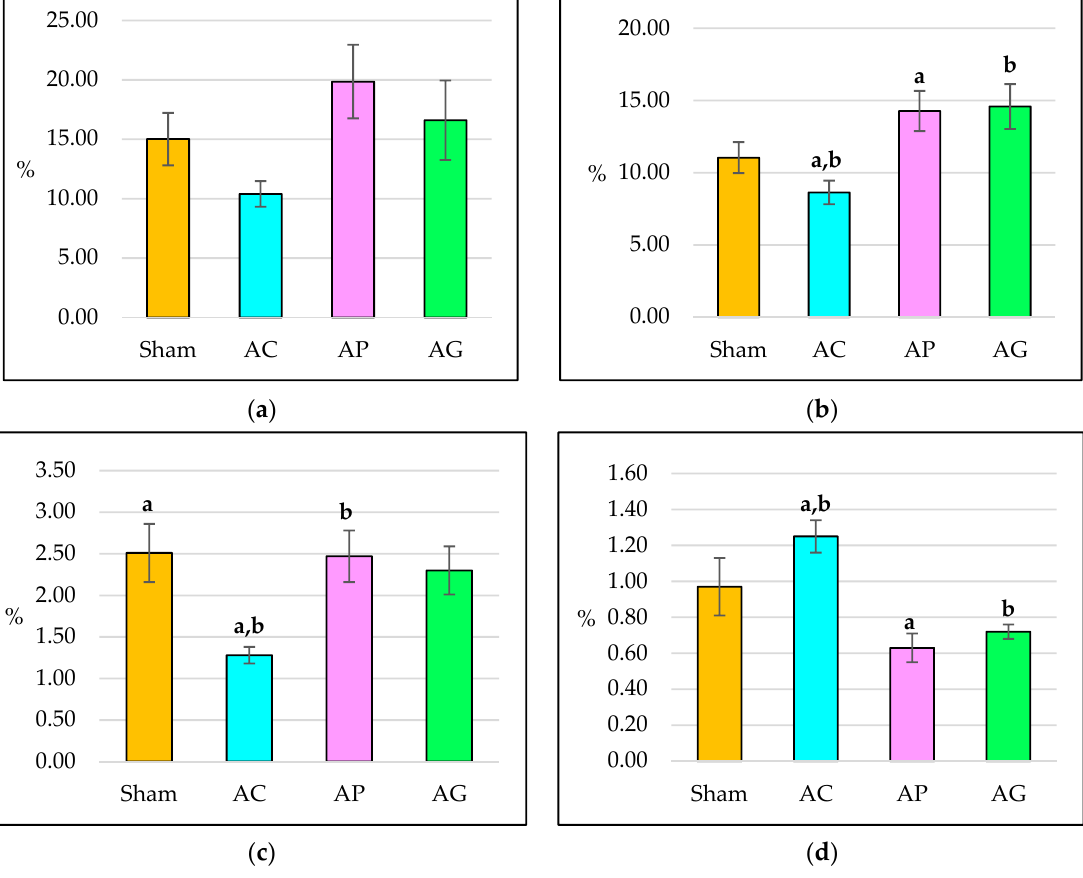
Figure 5. Static trabecular histomorphometry parameters after 8 weeks of treatment: ( a ) Osteoid volume (OV/BV); ( b ) Osteoid surface (OS/BS); ( c ) Osteoblast surface (Ob.S); ( d ) Osteoclast surface (Oc.S). AC: Adrx control given IM DEX 120 μ g/kg/day; AP: Adrx rats given IM DEX 120 μ g/kg/day and aqueous Piper sarmentosum extract 125 mg/kg/day; and AG: Adrx rats given IM DEX 120 μ g/kg/day and GCA 120 mg/kg/day. Data presented as mean ± SEM. The same letters indicate significant differences between groups at p < 0.05.